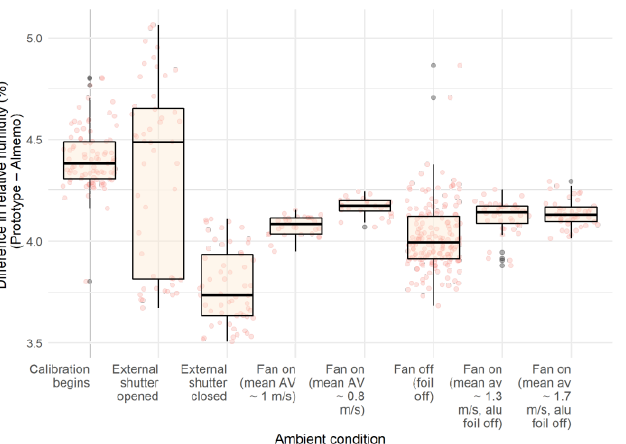
Figure A4. Difference in relative humidity recorded by the Arduino prototype and Almemo instru- ment during various ambient conditions.